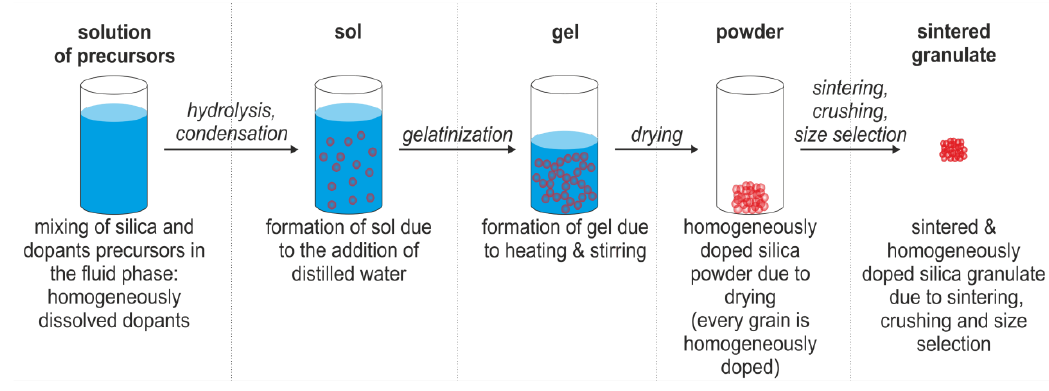
Figure 2. Basic principle of the sol-gel process [7].